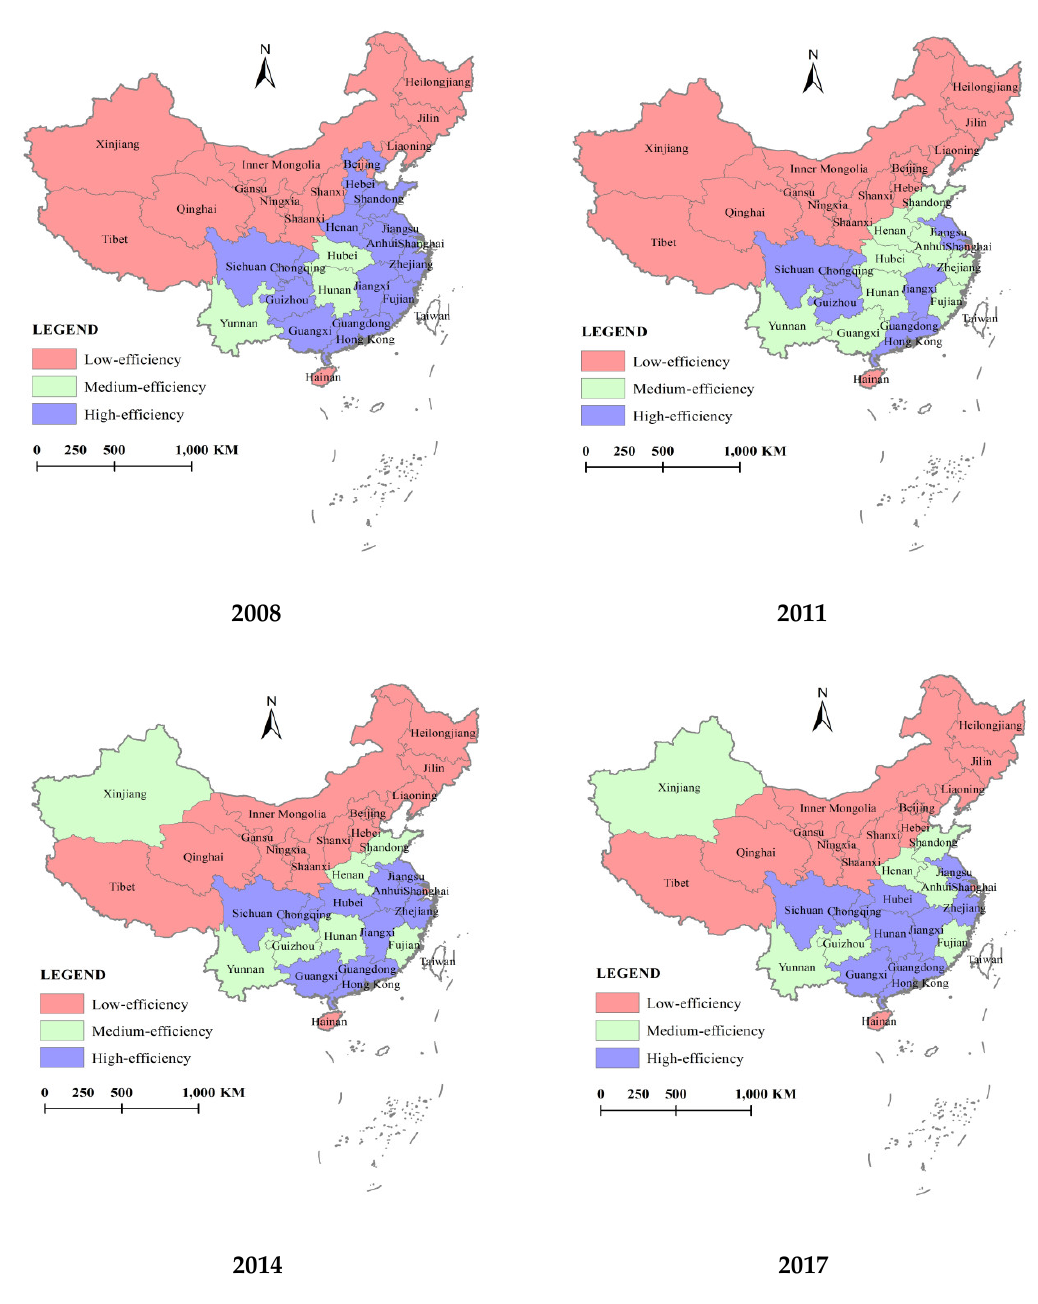
Figure 4. Spatial distribution of allocation e ffi ciency of rural public health resources in each province of China from 2008 to 2017.